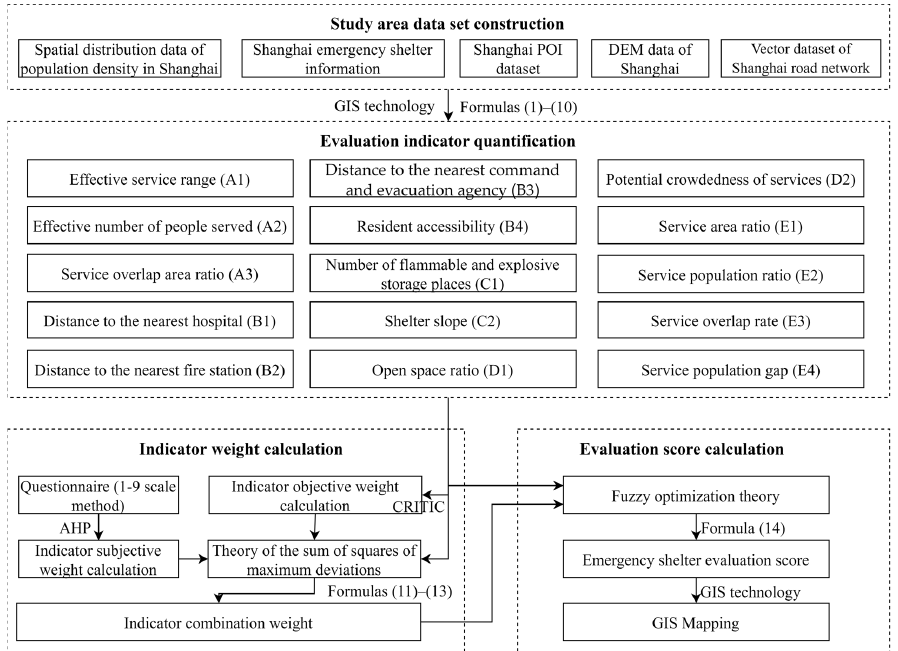
Figure 1. Technology roadmap.